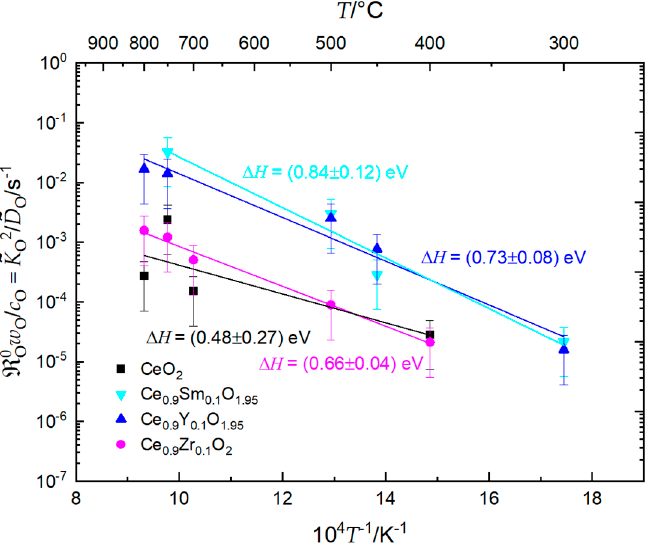
(cid:16) (cid:17) 2 w O ( x = 0 ) / c O ( x = 0 ) = / (cid:101) D O for non- (cid:101) K O O